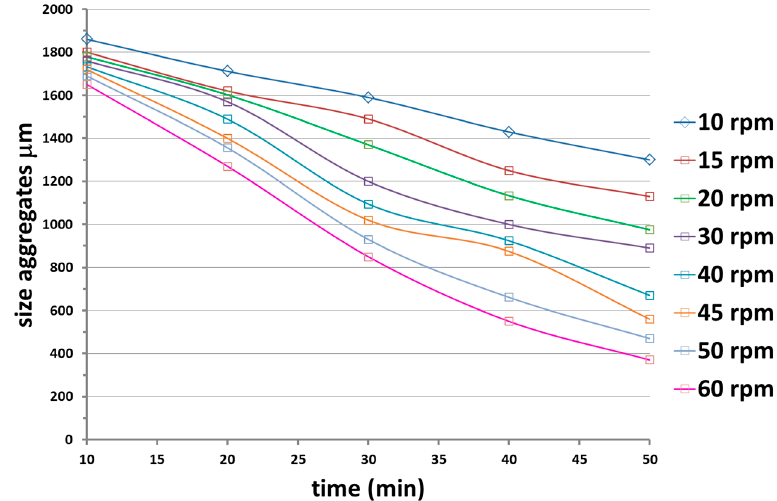
Figure 10. Evolution of the size aggregates with the time of application at different gears speed for a two gear head gearbox miller.